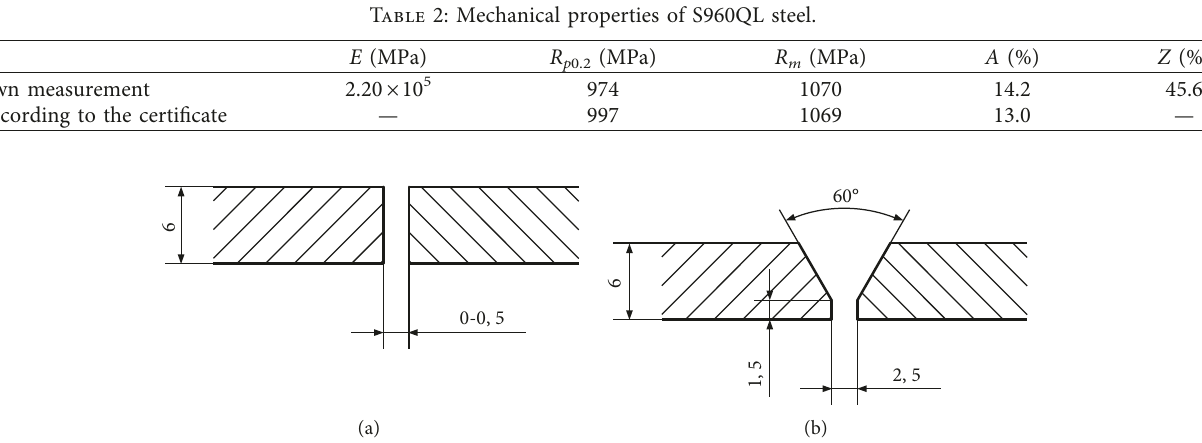
Figure 1: Geometry of welded elements prior to the implementation of joints: I-shaped (a) and V-joints (b).